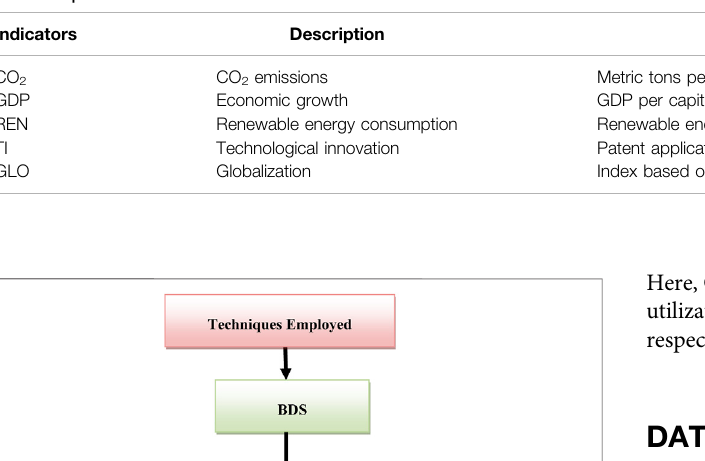
TABLE 1 | Variable unit and source.